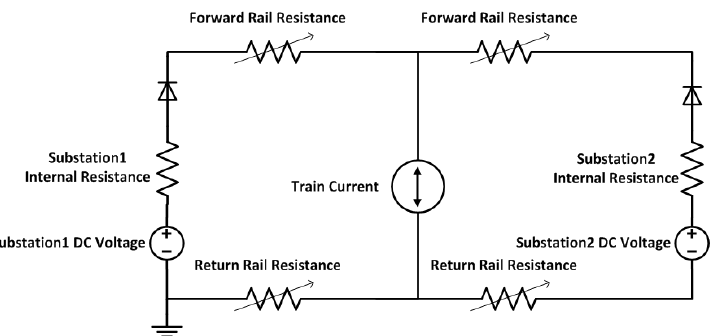
Figure 8. Electrical configuration of a train running between two successive substations.